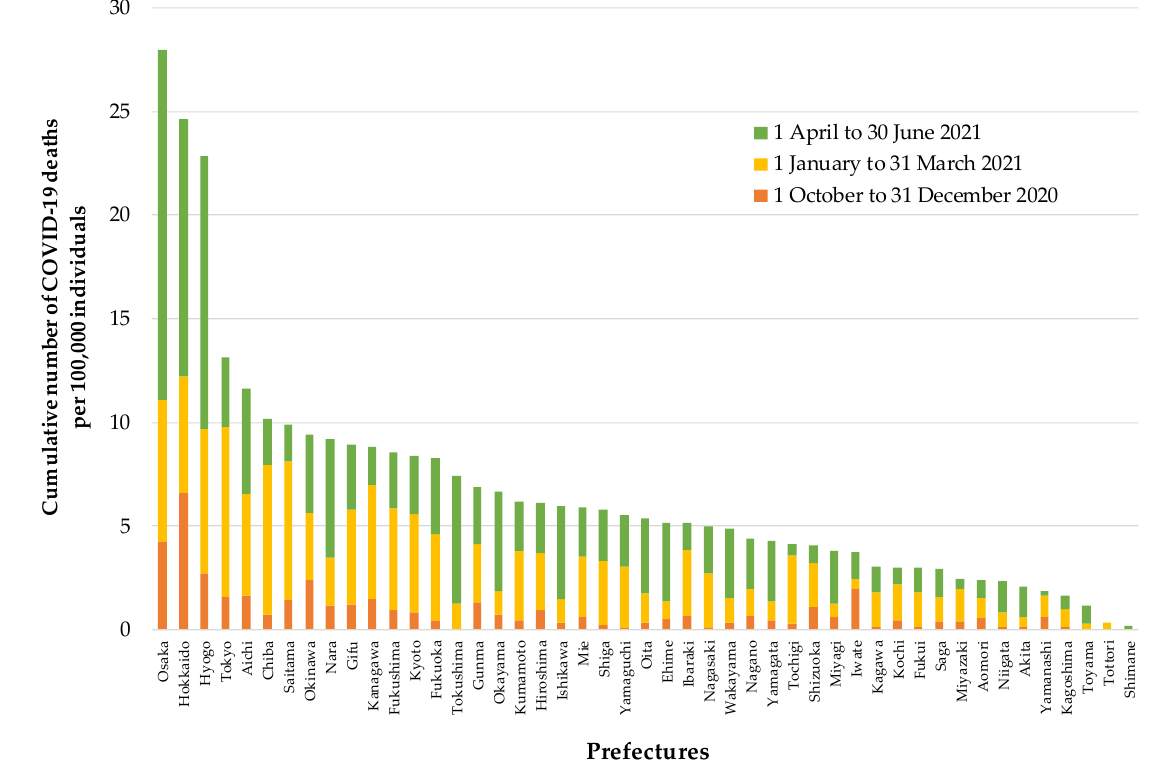
Figure 1. Distribution of the cumulative number of COVID-19 deaths per 100,000 individuals from 1 October 2020 to 30 June 2021, in 47 prefectures in Japan.